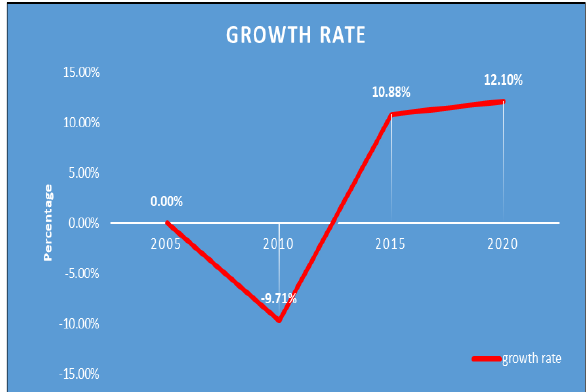
Figure 21. Growth rate in a 5-year